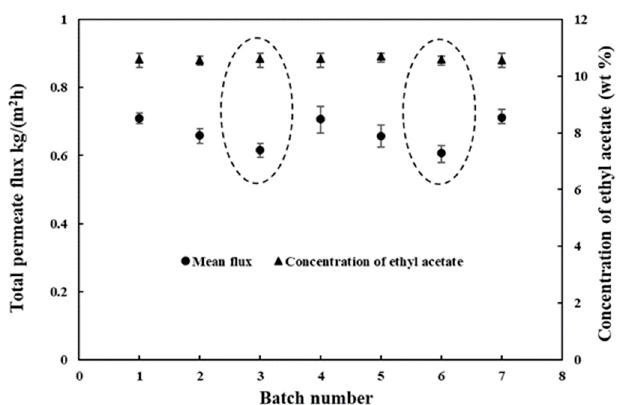
Figure 12. The effect of batches on the separation performance: ( ▲ ) Concentration of ethyl acetate (wt.%); ( ● ) Total permeate flux. The data of the third batch is emphasized because the backflushing process was needed to remove the deposited salt. (The composition of feed solution is listed in Table 3; operation temperature is 40 °C.).